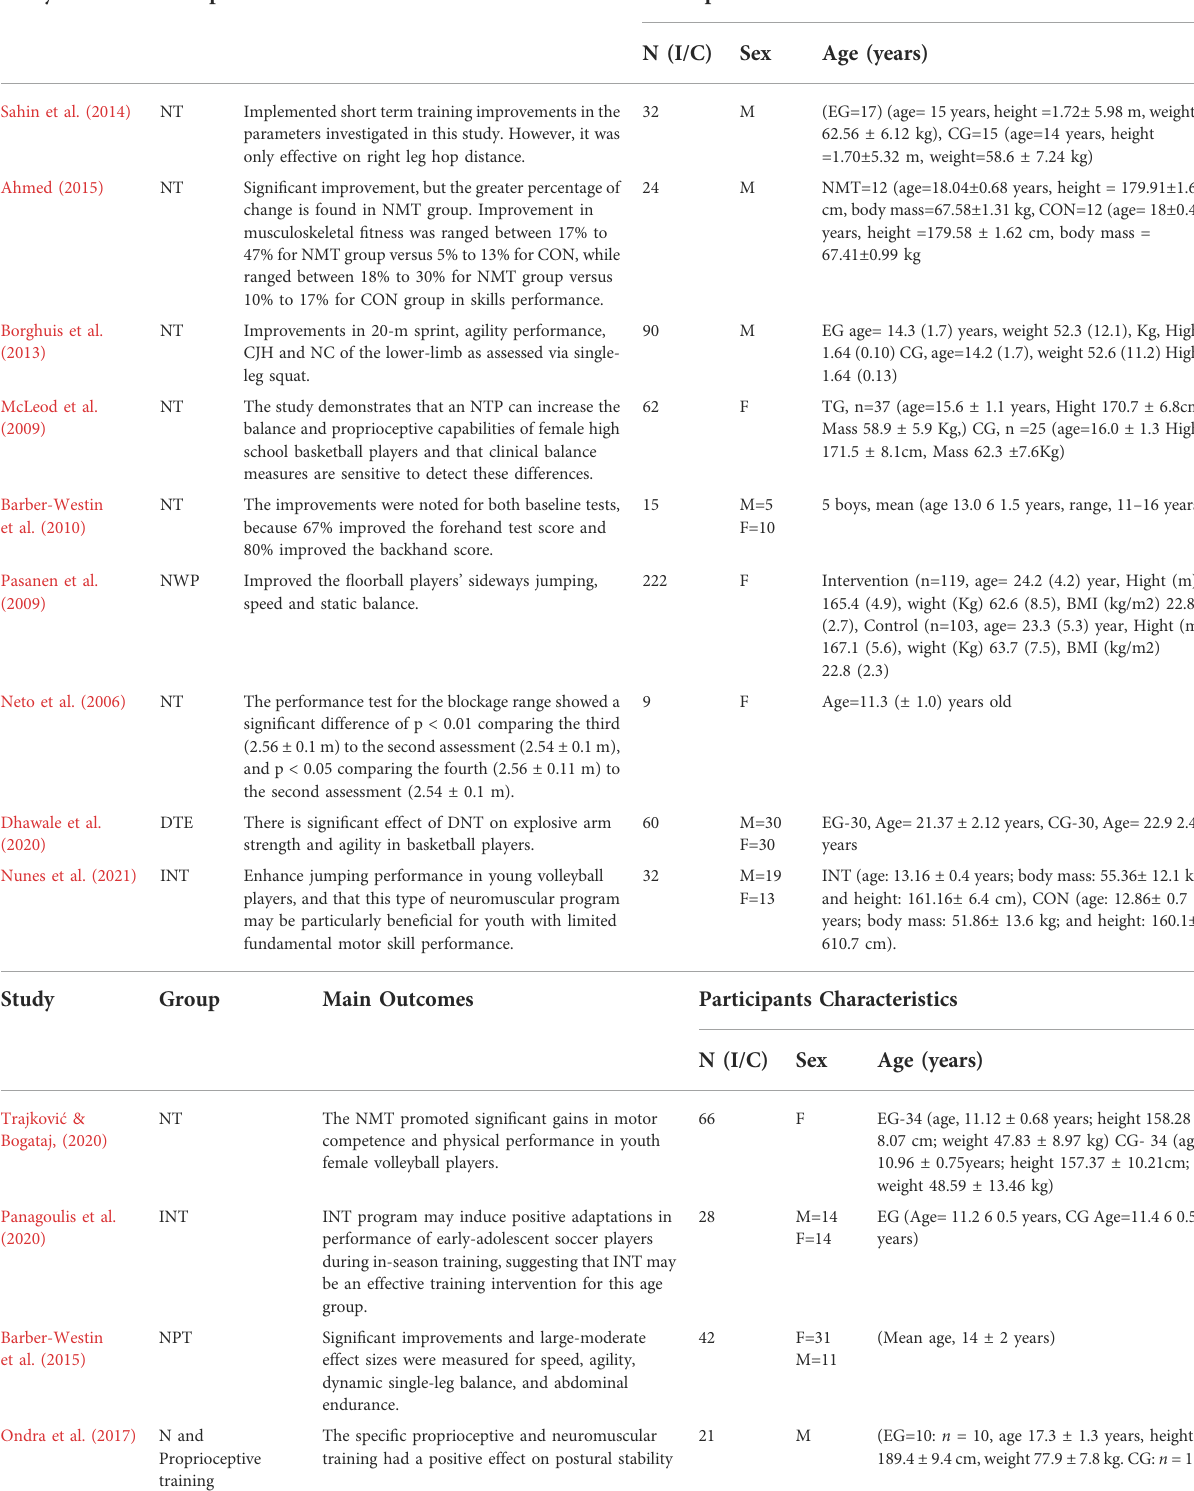
TABLE 3 Group, Main outcomes, and participants